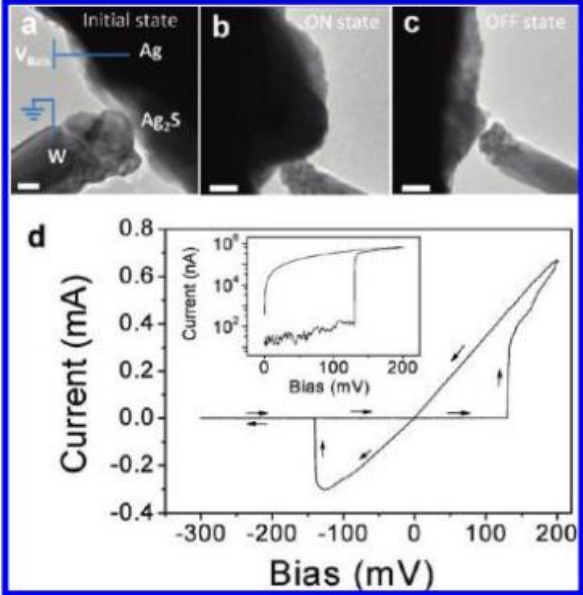
Figure 4: Low-magnification TEM image of Ag 2 S-based ReRAM. Low-magnification TEM image corresponding to (b) LRS of the device, due to the growth of a new nanocrystal (c) HRS, the newly grown crystal, Low magnification TEM image corresponding to the off-state. The grown crystal disappeared. Pinched hysteresis loop of Ag 2 S-based ReRAM in (d) linear scale Inset: logarithmic scale. (Reprinted with permission from Z. Xu, Y. Bando, W. Wang, X. Bai and D. Golberg // ACS Nano 4 (2010) 2515 (C) 2013 American Chemical